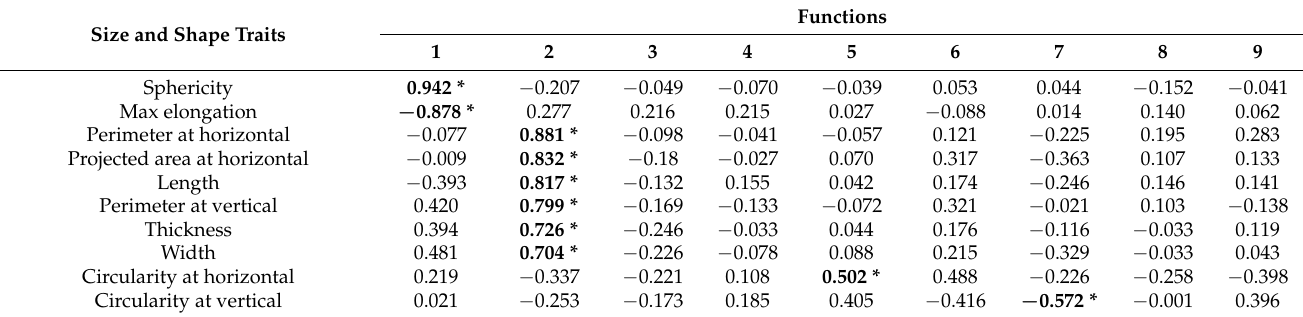
Table 4. The correlations between discriminating variables and standardized canonical discriminant functions. Size and Shape Traits